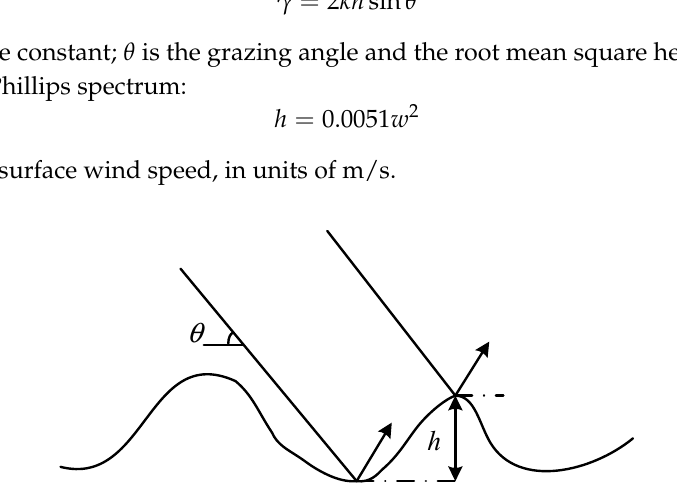
Figure 2. Schematic diagram of Rayleigh roughness parameters. The Rayleigh roughness factor γ represents the phase change between two reflecting rays at the grazing angle θ and root mean square height difference h . When γ is small, the reflection line of electromagnetic wave is approximate to the same phase, so the surface can be approximated to a smooth surface.